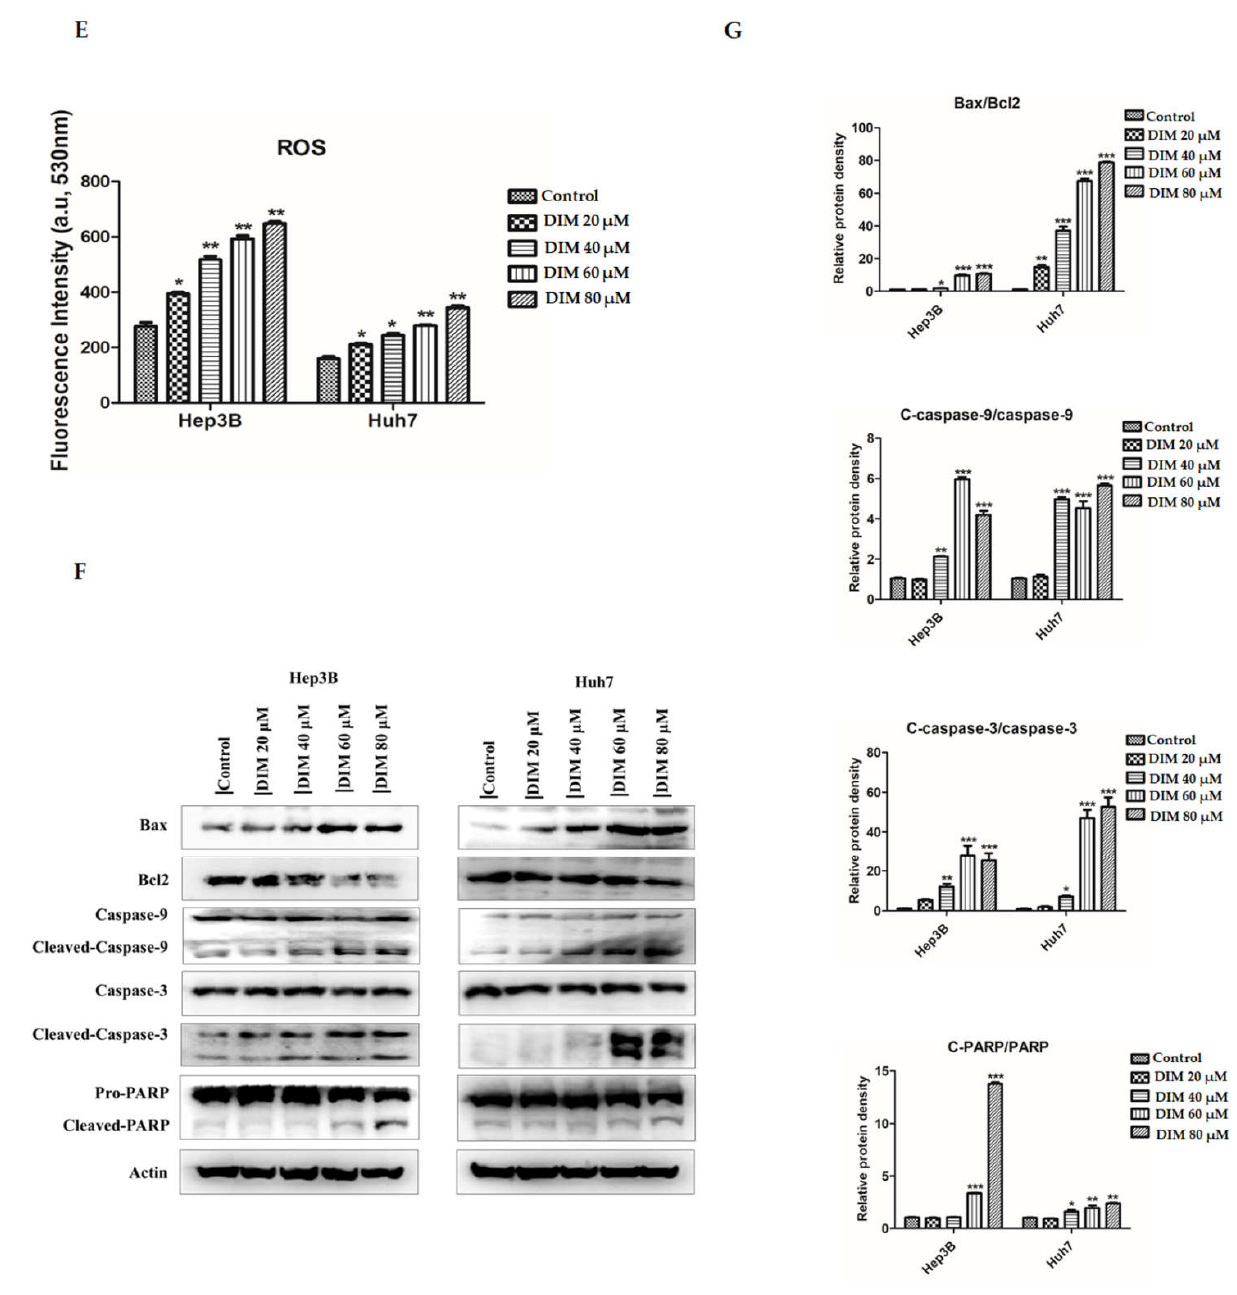
Figure 4. DIM induces apoptosis in HCC cell lines by releasing ER Ca 2+ and disrupting mitochondrial membrane potential. ( A , B ) Respective cell lines and bar graph showing the relative amount of Ca 2+ flux induced by DIM in Hep3B and Huh7 cells determined by monitoring changes in the Fura-2 ratio upon addition of 1–5 µM thapsigargin using the real-time mode of a PTI system. ( C ) Bar graphs representing quantitative assessment ( % ) for the depletion of mitochondrial membrane potential (ΔΨm) induced by DIM in Hep3B and Huh7 cells using an ELISA reader after staining with tetramethylrhodamine ethyl ester perchlorate (TMRE). ( D ) The amount of intracellular ROS accumulated after DIM treatment in Hep3B and Huh7 cells was evaluated by monitoring the intensity of the ROS fluorescent probe, dihydroethidium (DHE), using a confocal microscope. Scale bar, 30 µm. ( E ) Bar graphs show the amount of ROS induced by DIM treatment in Hep3B and Huh7 cells determined by calculating the relative fluorescence unit (RFU)/µg protein with an Oxi Select In Vitro ROS/RNS Assay Kit according to the manufacturer’s instructions. ( F ) Changes in protein levels of pro-apoptotic and anti-apoptotic related marker induced by DIM treatment as determined by Western blot analysis. ( G ) Quantification of relative protein expression normalized to β -actin. Cells were treated with DIM for 24 h. Provided data represents the mean ± SE of three independent experiments. *, p < 0.05; **, p < 0.01; and ***, p < 0.001 denote significant variation compared to the control group.